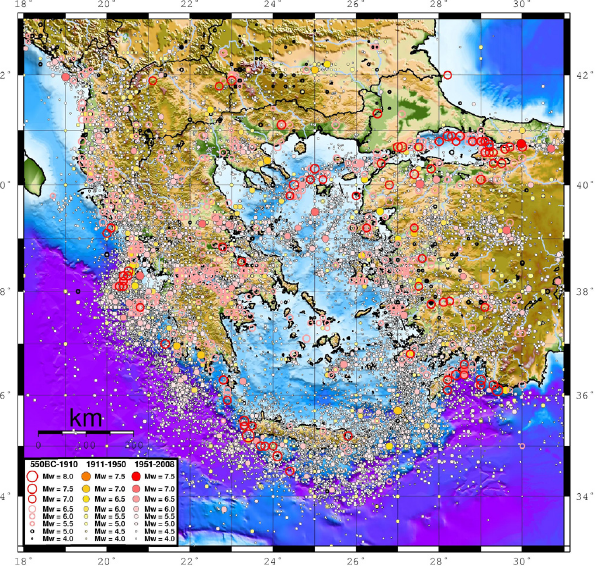
Figure 5. Map of the epicentres of all known shallow ( h <50km) earthquakes ( M ≥ 4.0) which occurred in the broader Aegean/southern Balkan area during the time period 550BC–2008. The colour and type of circles denote the magnitude scale and the time period, respectively.